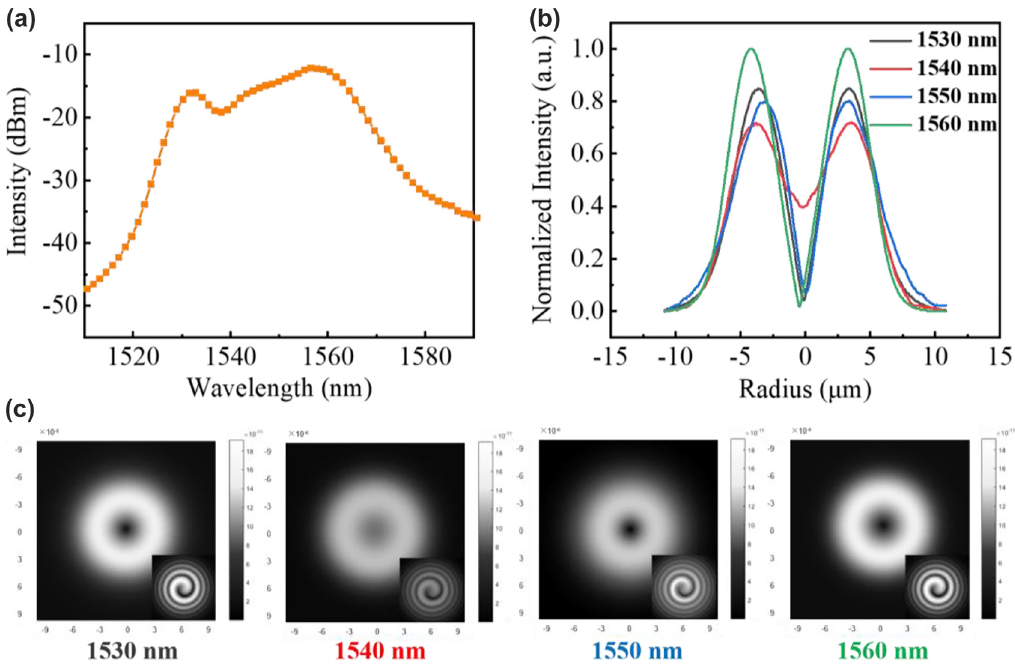
Figure 5: Theoretically OAM fluorescence emission in the RC-EDF. (a) Fluorescence spectrum. (b) Normalized intensity, (c) mode pattern and mode at the wavelength of 1530, 1540, 1550, and 1560 interferogram of OAM 1